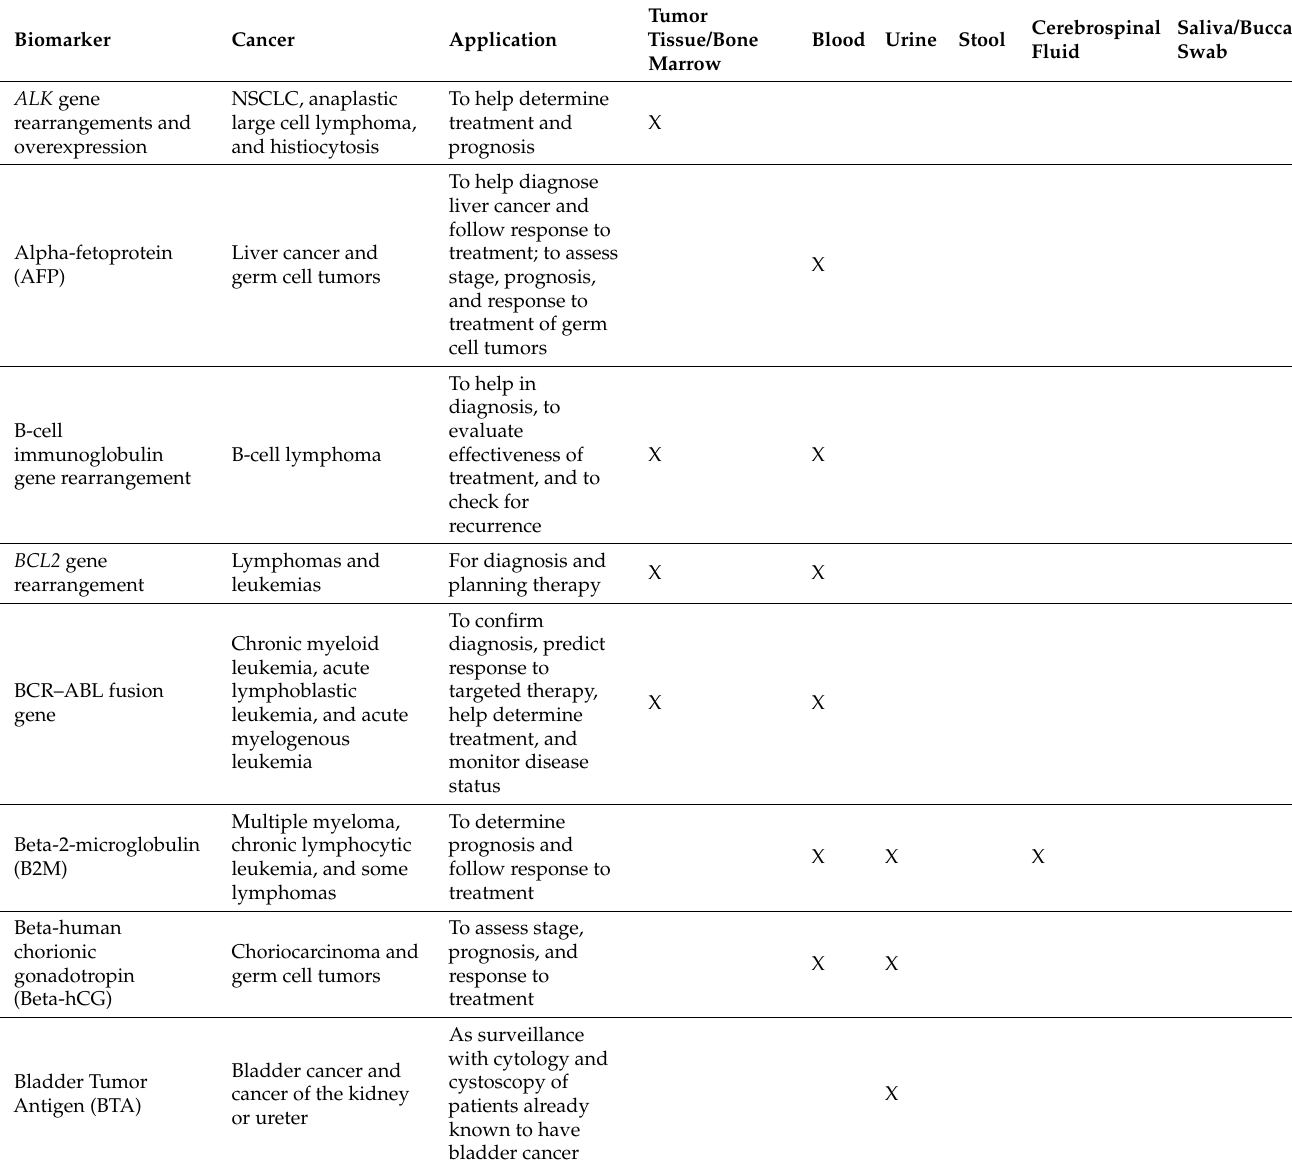
Table 2. Commonly studied cancer biomarkers from different sample types. (source: National Cancer Institute [91], and references